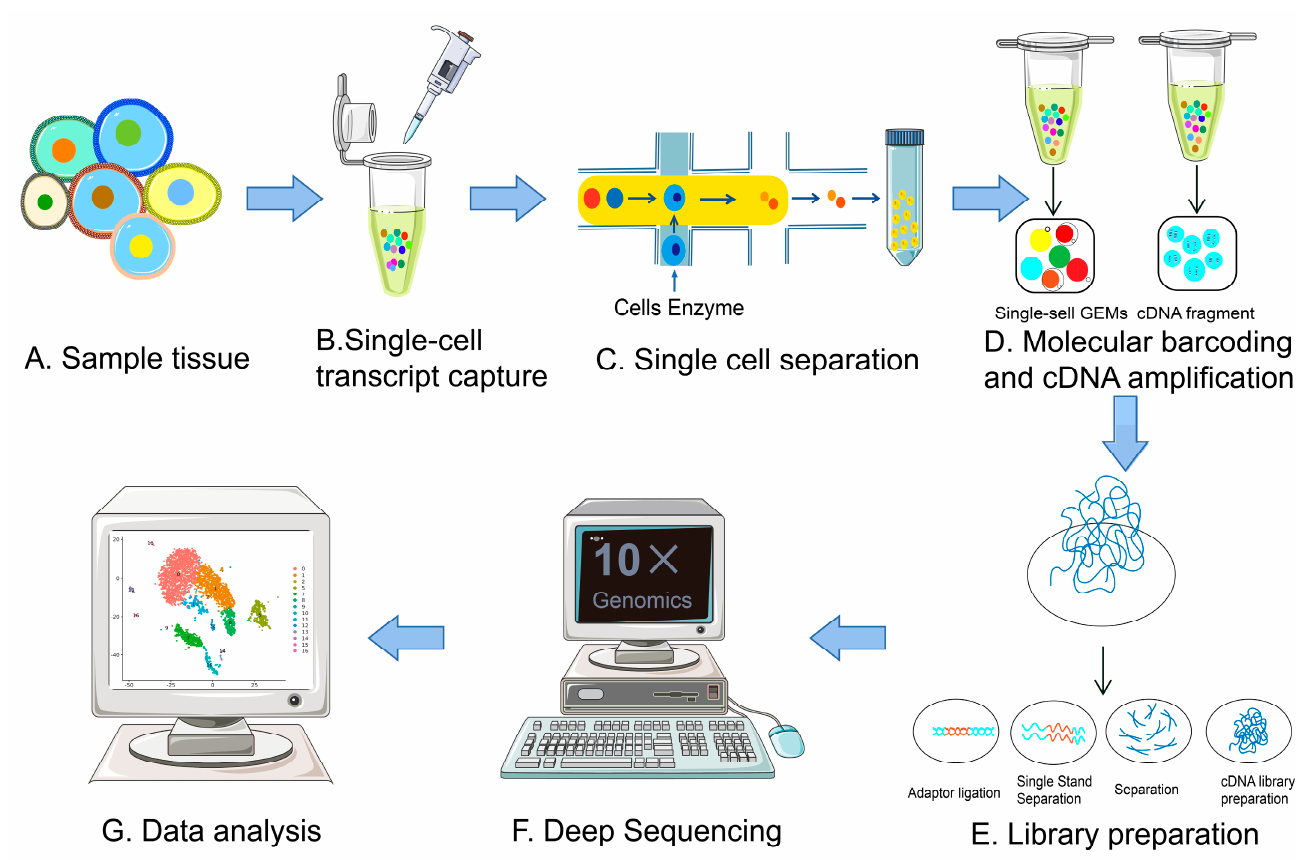
Figure 1. An overview of the single-cell RNA-sequencing procedures. ( A ) collect cells from tissue samples. ( B ) Single-cell capture process. ( C ) Cell isolation process. ( D ) Reverse transcription of mRNA and amplification of cDNA. ( E ) Construction of the scRNA-Seq library. ( F ) Complete deep sequencing of scRNA-Seq. ( G ) Analysis of scRNA-Seq data.